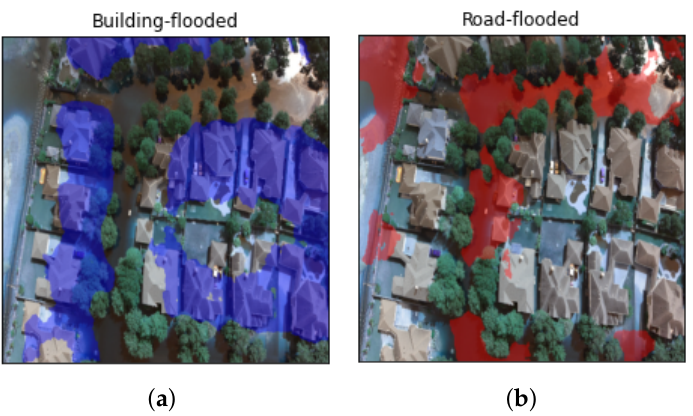
Figure 6. Segmentation mask for the classes of interest. ( a ) Blue mask over flooded buildings; ( b ) Red mask over flooded